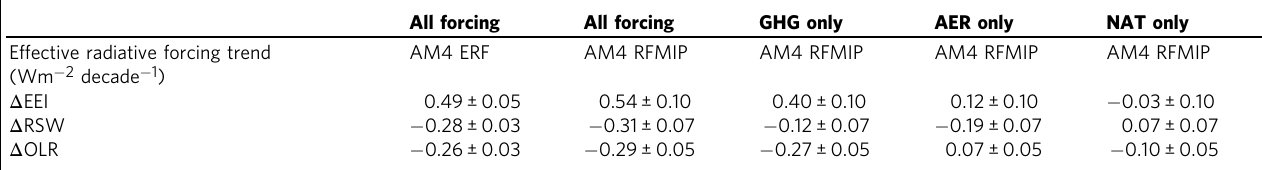
Table 1 Decomposition of effective radiative forcing trends into greenhouse gas, aerosol, and natural radiative forcing contributions during